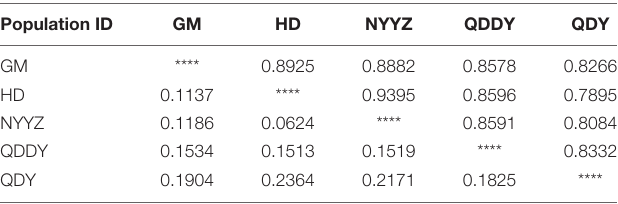
TABLE 7 | Analysis of molecular variance for the five populations of M. vulgaris based on microsatellites. Source of variation d.f. Sum of Among populations Within